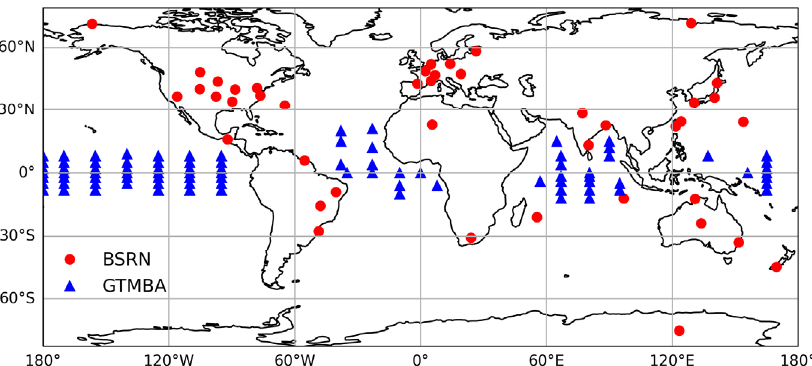
Figure 1. Spatial distribution of Baseline Surface Radiation Network (BSRN) stations (red dots) over the global land surface and Global Tropical Moored Buoy Array (GTMBA) buoy stations (blue triangles) over the ocean.